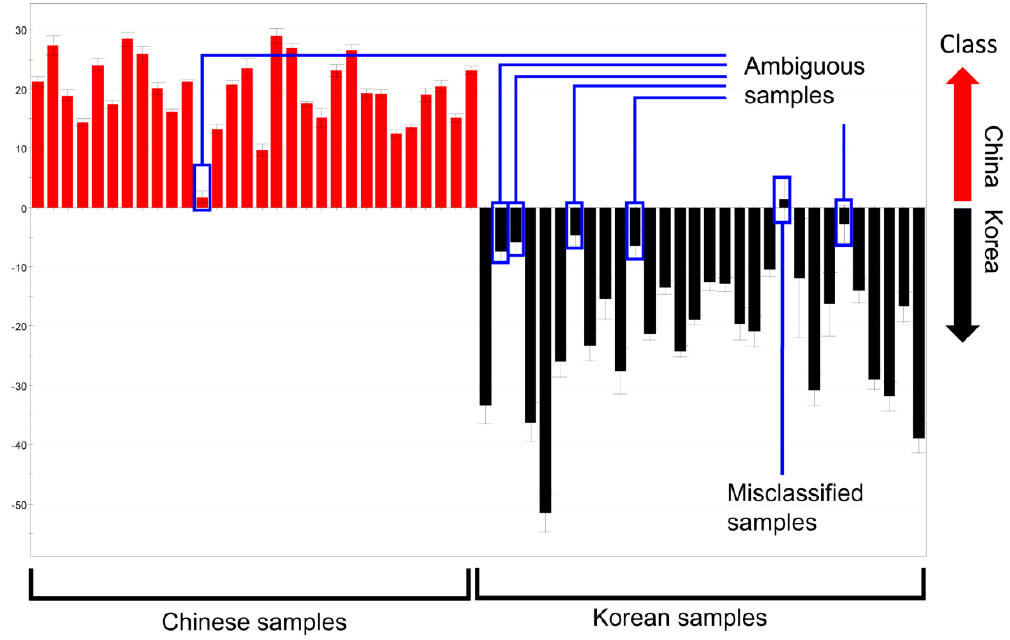
Figure 3. PC1 column plots of R. glutinosa analyzed by GC-MS (enlarged version of Figure 2g). Ambiguous samples and misclassified samples are indicated.